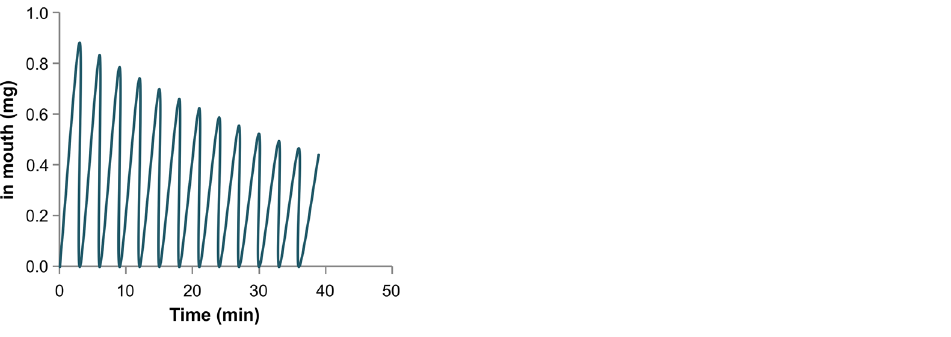
Figure 5. Amount of nicotine in the saliva predicted by the dissolution model over 40 min of MST use. It rises before two expectorations and rapidly drops after each